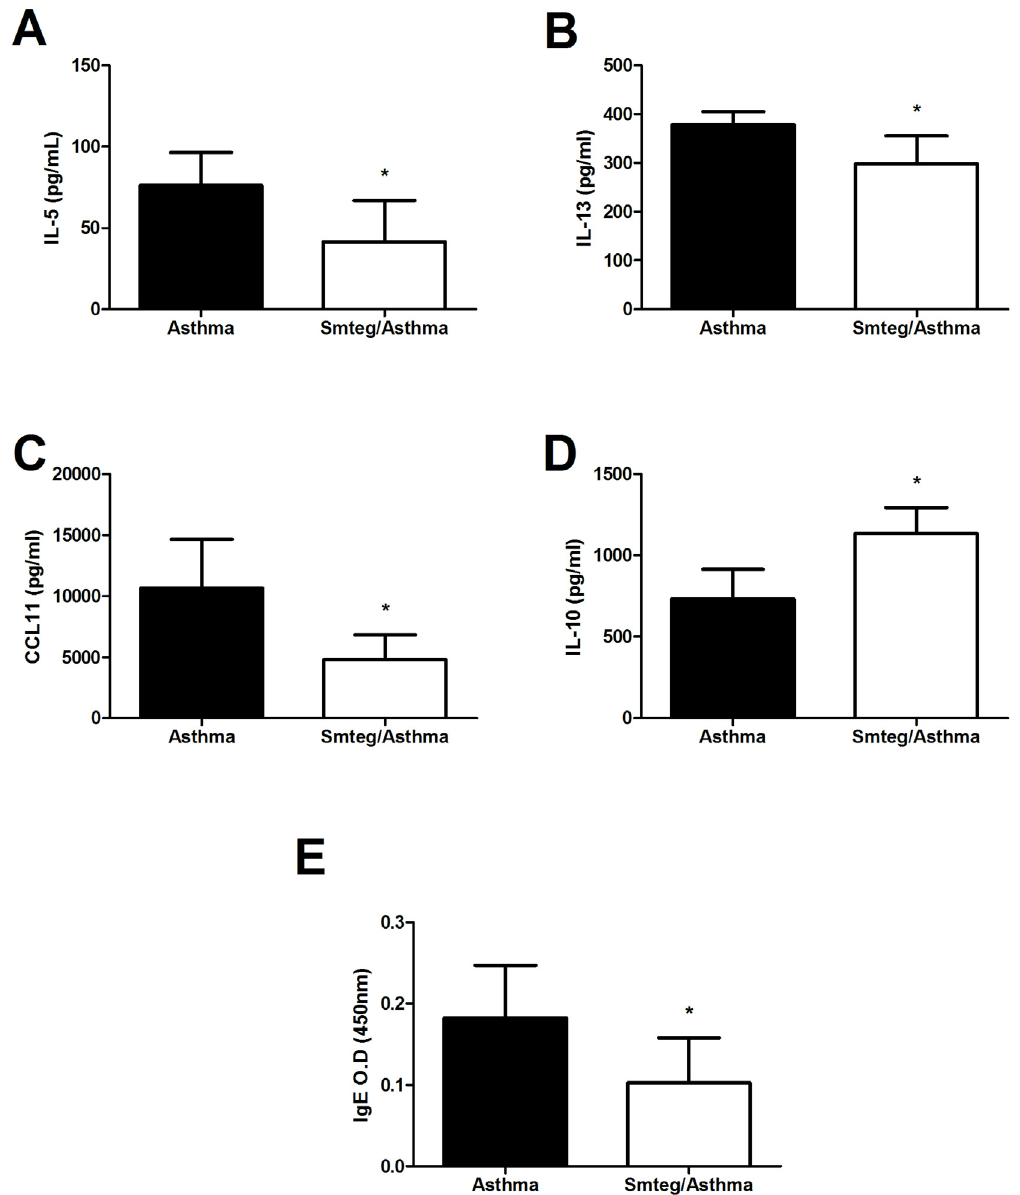
Fig 3. Smteg treatment reduced inflammatory parameters of airway inflammation. The production of ( A ) IL-5, ( B ) IL-13, ( C ) CCL11 and ( D ) IL-10 was evaluated in the lungs of mice. The Smteg/Asthma group presented lower levels of inflammatory cytokines (A-C) while showed up-regulation of IL-10 (D), compared to Asthma group. Moreover, ( E ) OVA-specific IgE levels in sera of mice were reduced due to Smteg treatment. * p < 0,05; Student's t test; O.D = Optical Density. Data are representative of 2 independent experiments. Results are presented as mean ± SD.